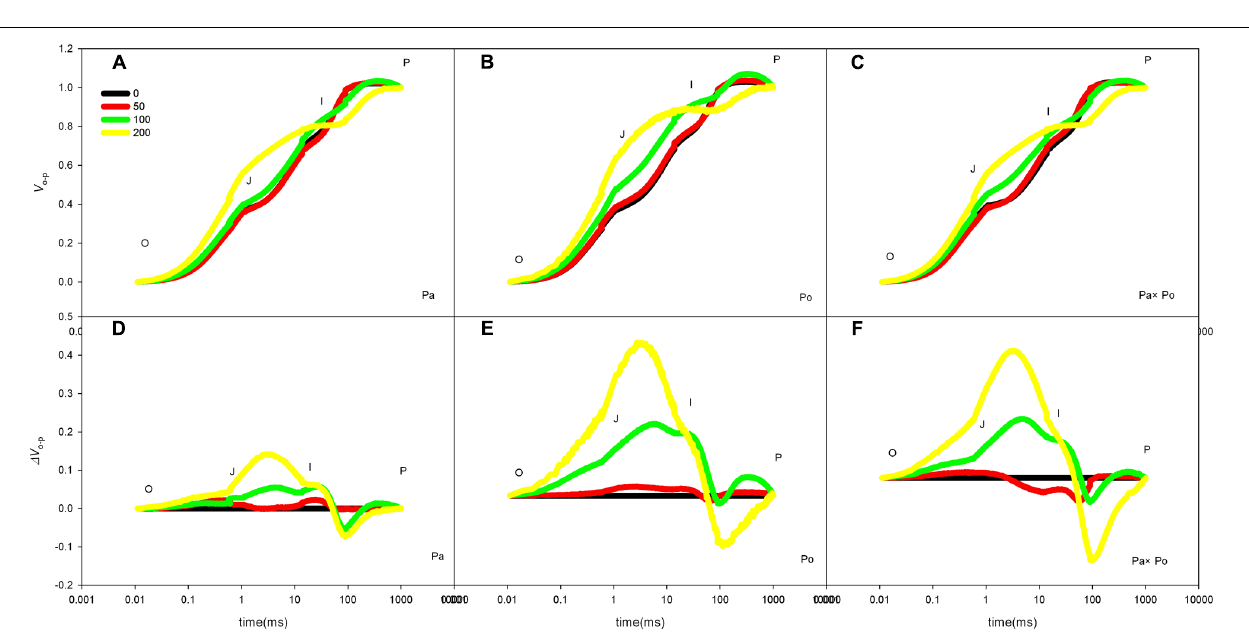
FIGURE 4 | The effect of salt stress on the standardized OJIP curves of leaves of three P. amurensis . The effect of salt stress on the standardized OJIP curves of P. amurensis (A,D) . The effect of salt stress on the standardized OJIP curves of P. opulifolius “Diabolo” (B,E) . The effect of salt stress on the standardized OJIP curves of hybrid P. amurensis (C,F) . Note: Pa, P. amurensis Maxim ( Data in the figure are mean ± SE; values followed by different lowercase letters indicate a significant difference ( p <